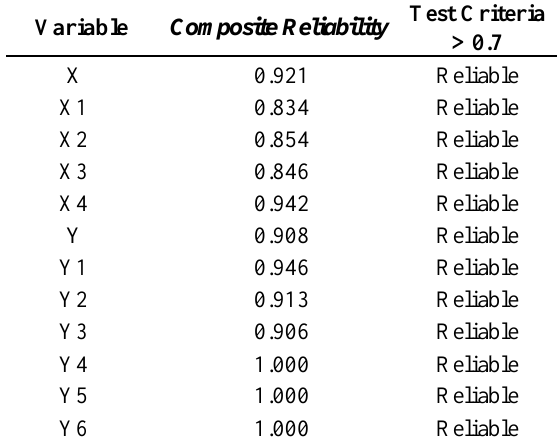
Table 6 Composite Reliability Test Analysis